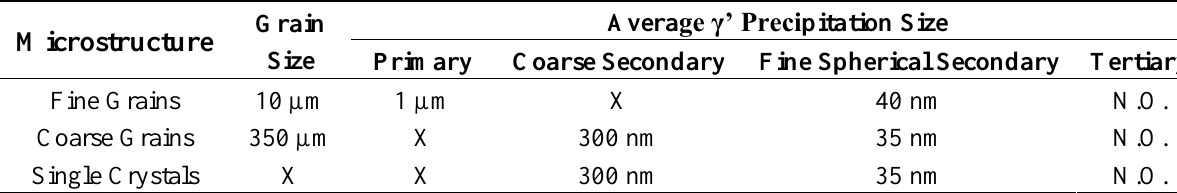
Table 2. Characteristics of the three microstructures (N.O. = Not